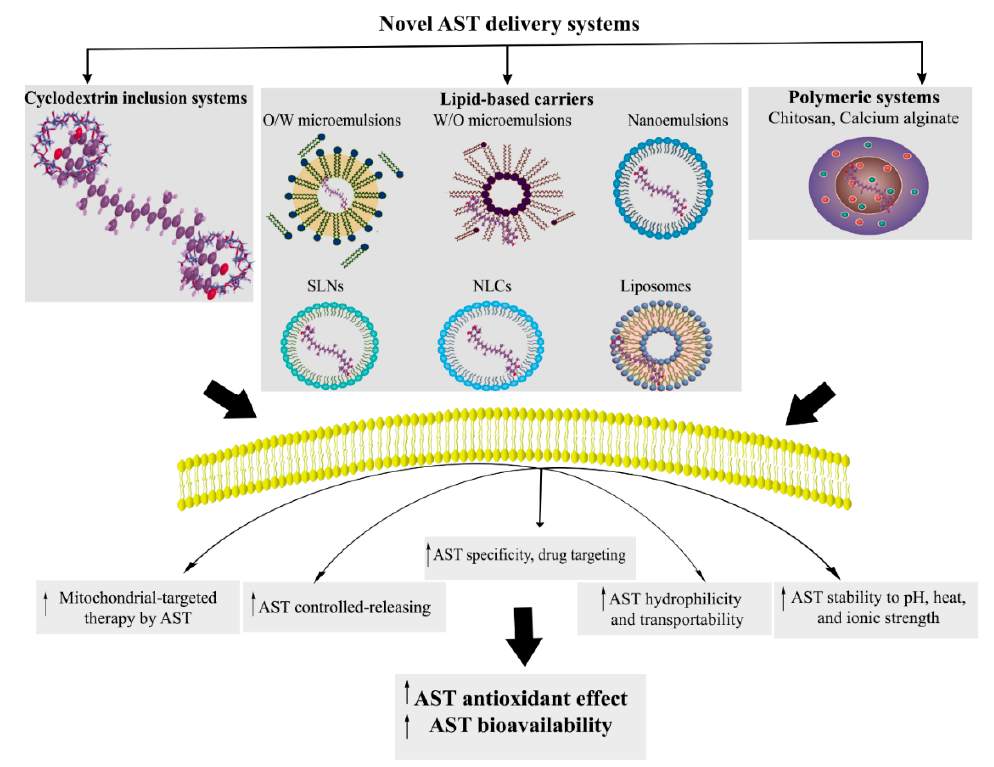
Figure 3. Novel AST delivery systems. O / W: oil in water, W / O: water in oil, SLNs: solid lipid nanoparticles, NLCs: nanostructured lipid carriers, and AST: astaxanthin.